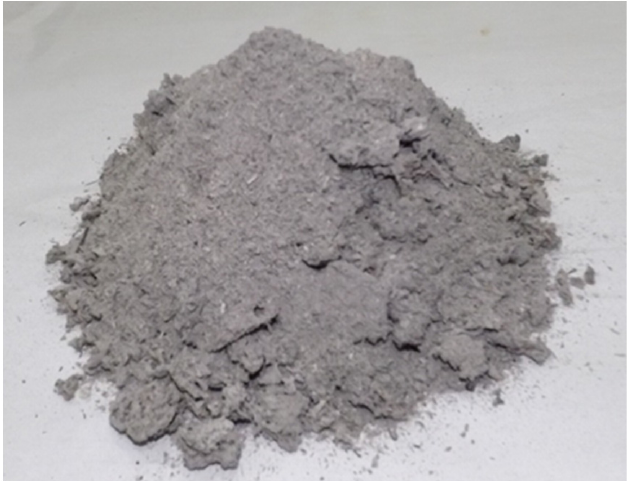
Figure 1. Raw ash resulted from the free burning of sunflower stalks.